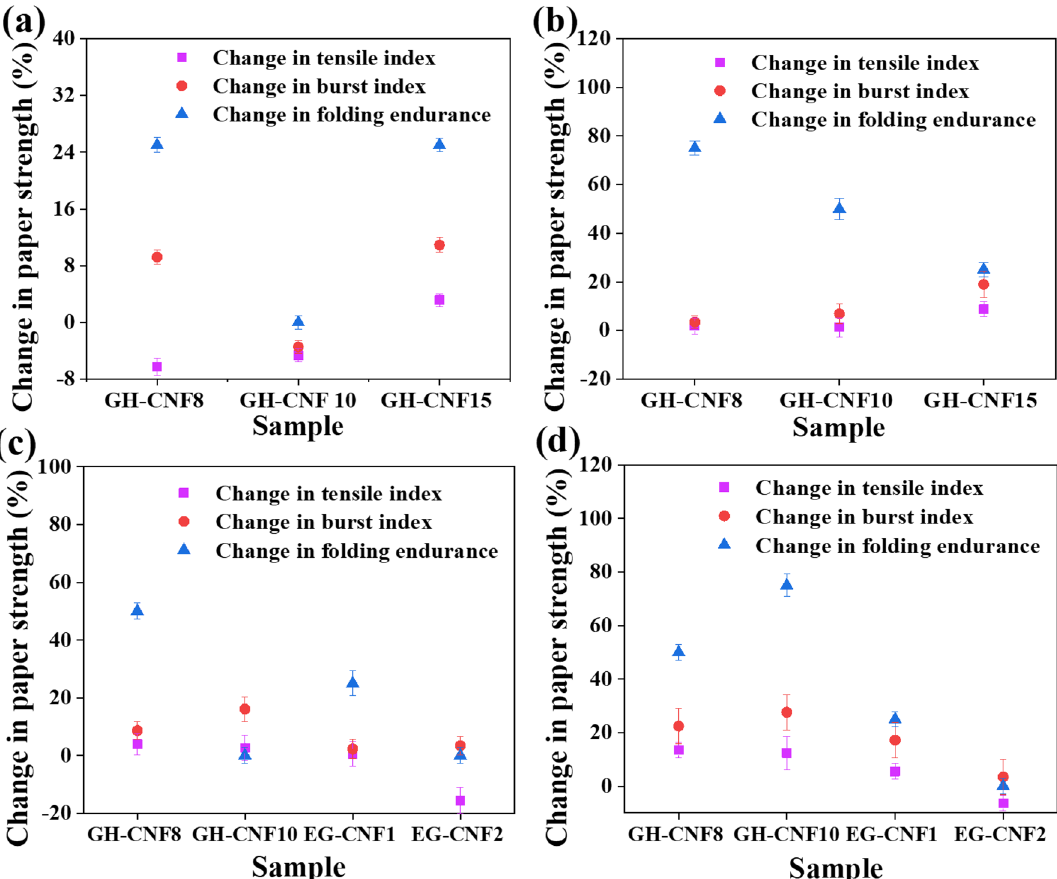
Figure 7. Change in mechanical strength of papers from recycled pulp A strengthened with different CNFs at dosage of ( a ) 1.0 wt%, ( b ) 2.0 wt%, ( c ) 3.0 wt%, and ( d ) 5.0 wt%. All the numbers were normally distributed. The points shown on the figure were average numbers of all the tested specimens and the error bars displayed the standard deviation of all the numbers acquired through testing.